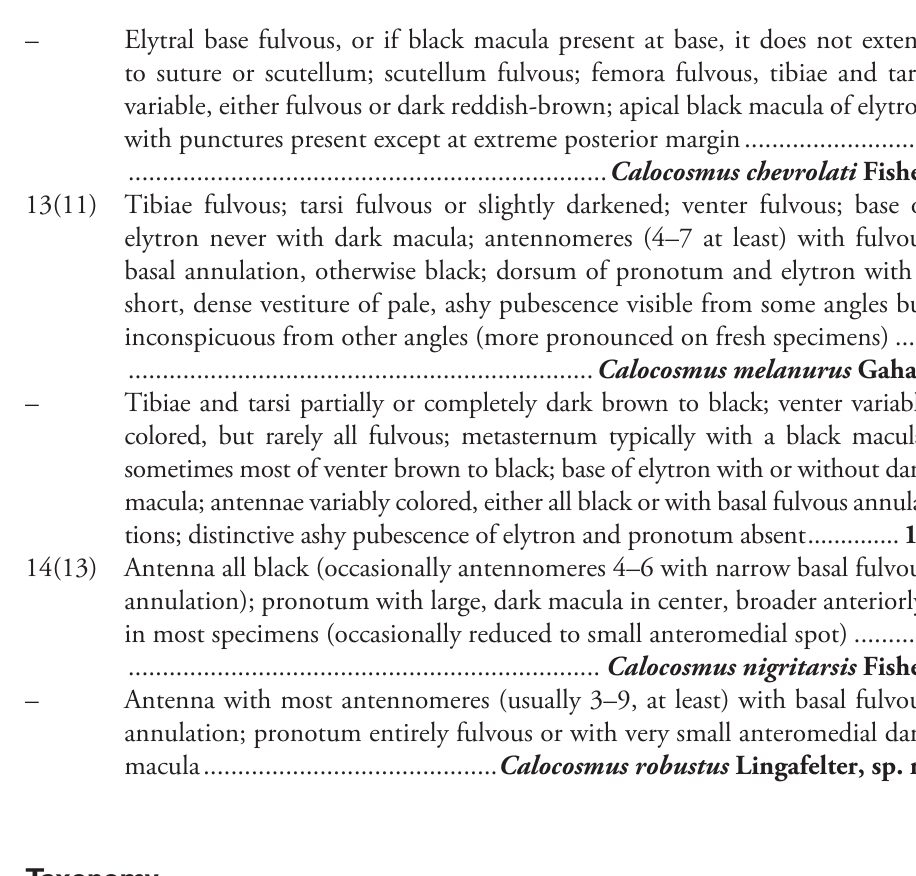
Adesmus fortunei Lingafelter, sp. n.